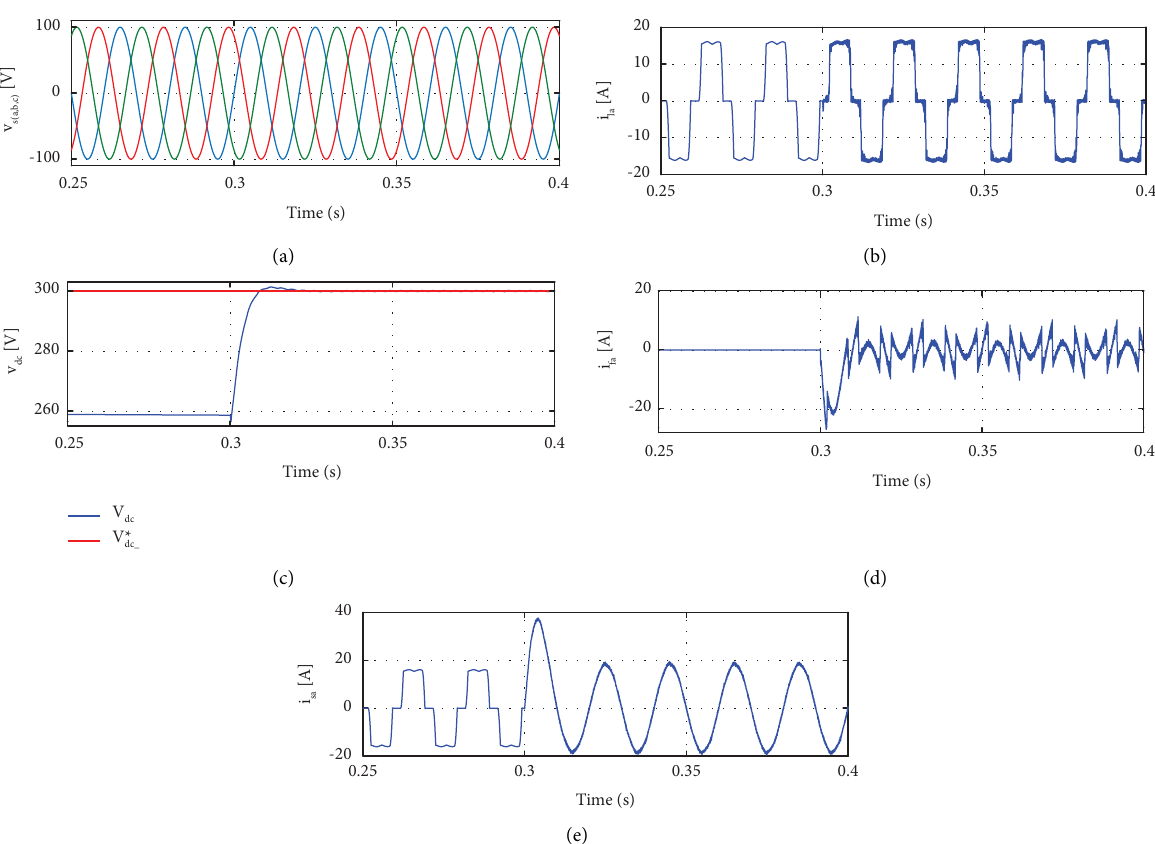
), (b) load current ( i l1 ), (c) voltage DC-link ( v sk